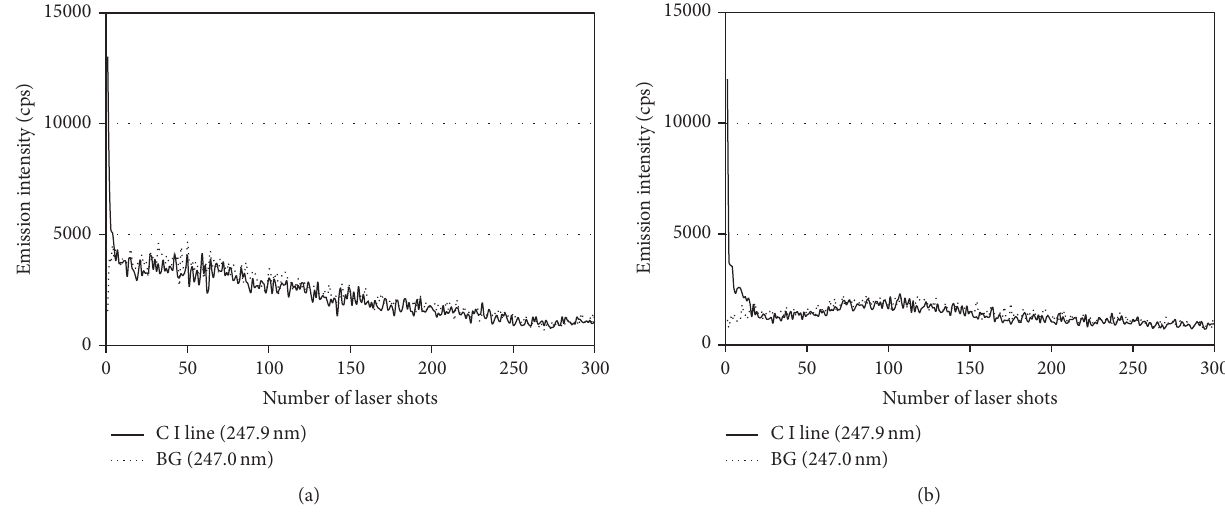
Figure 6: Emission signals from both C (247.9 nm) and background (247.0 nm) observed for Cd under (a) Ar and (b) He chamber gas conditions as a function of laser